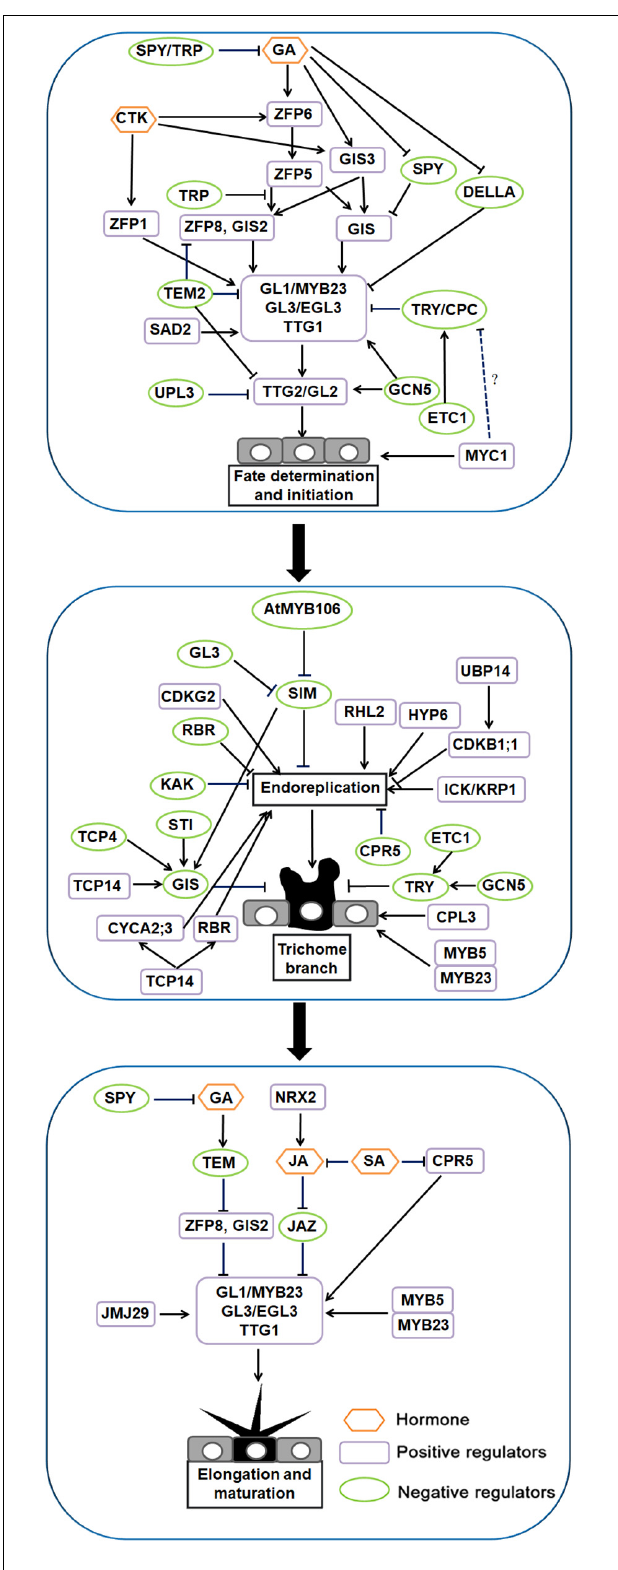
FIGURE 1 | Regulatory network model for trichome development in Arabidopsis